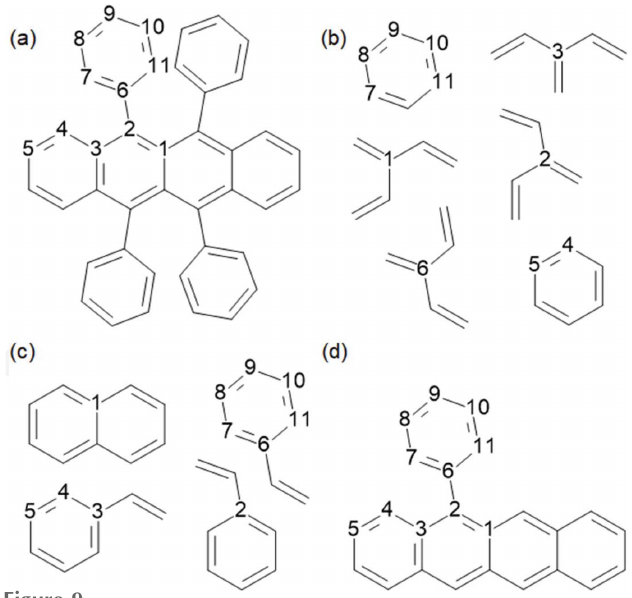
Figure 9 Fragmentation of rubrene according to models (1)–(3) discussed in the text: ( a ) atom labels (when an atomic density for a given atom is taken from a given fragment, the atom in the fragment is enumerated), ( b ) fragmentation according to scheme (1), ( c ) scheme (2) and ( d ) scheme